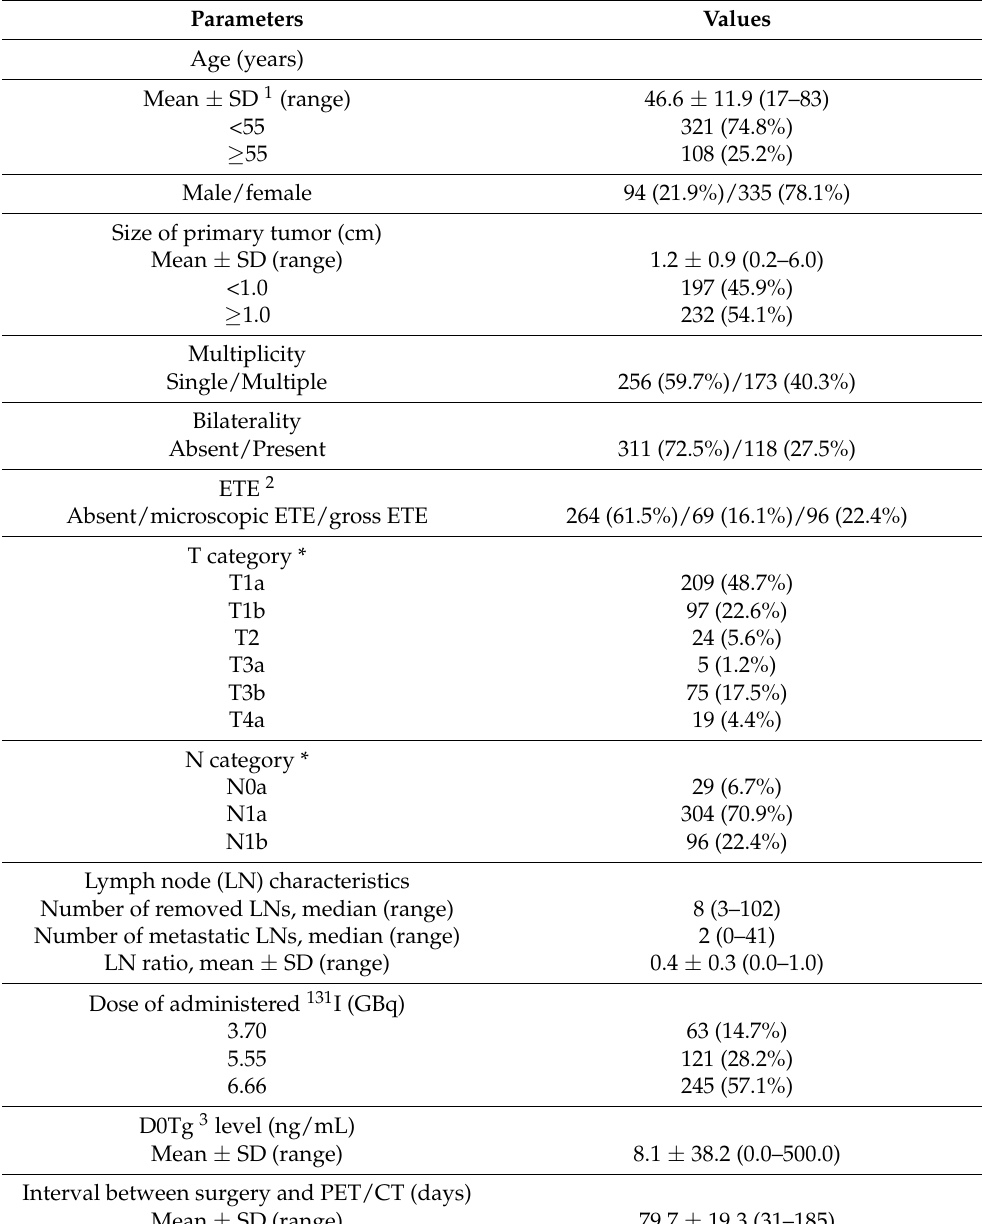
Table 1. Patient characteristics ( n =